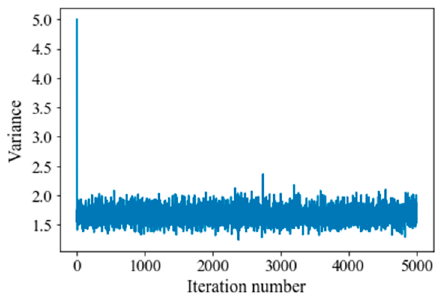
Figure 8. The seismic noise variance sampling versus the iteration number.